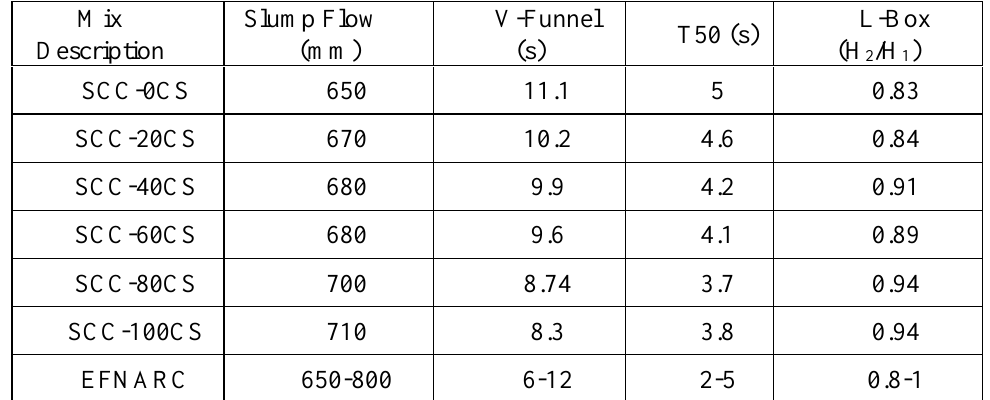
Table 4. Fresh properties of SCC compared with EFNARC